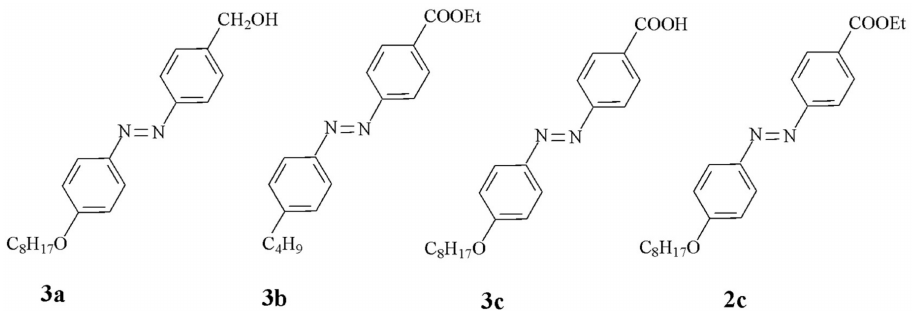
Scheme 2. Molecular structure of compounds 3a–c and compound